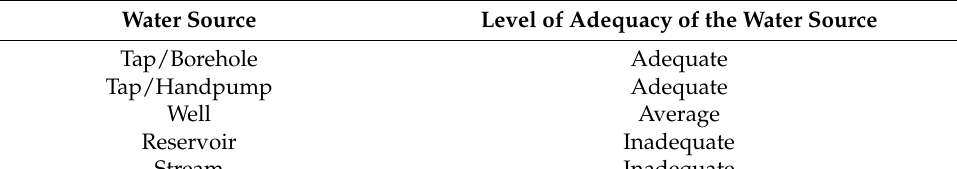
Table 2. The various water source with description of the level of adequacy.